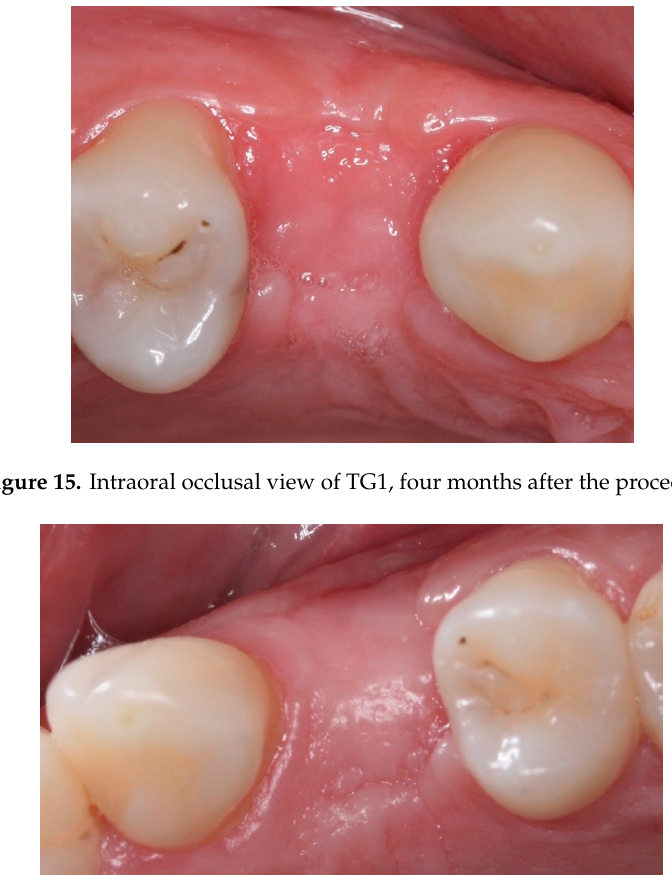
Figure 16. Intraoral occlusal view of TG2, four months after the procedure.